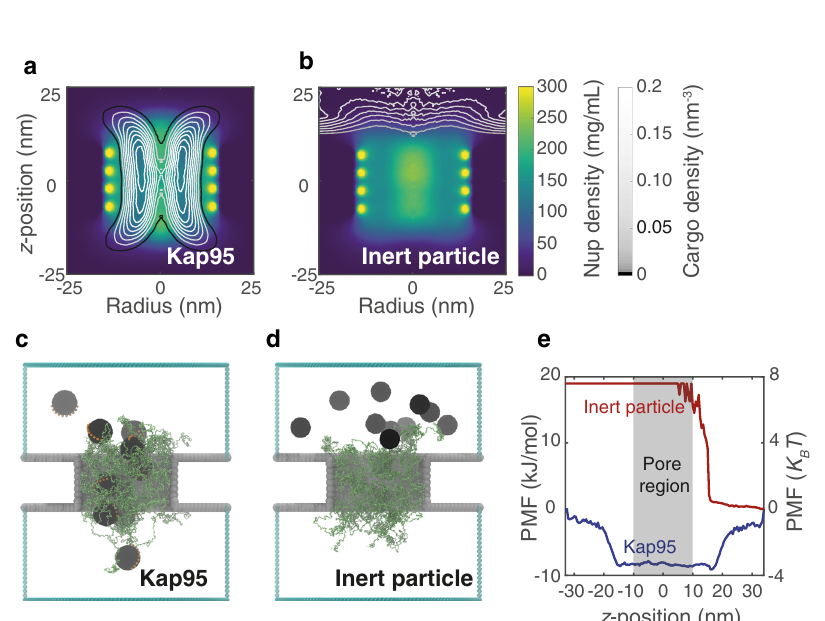
Fig. 4 Protein distribution and conductance of NupX-coated pores. a Snapshot of a biomimetic nanopore simulation. NupX proteins (following the colouring scheme of Fig. 1) were tethered with a grafting distance of 5.5 nm (yellow, top inset) to a cylindrical occlusion made of inert beads (grey). Pore diameters ranged from 15 to 70 nm, where the pore thickness was 20 nm throughout. Bottom inset: highlight of a single NupX protein (purple) within the NupX meshwork. b Axi-radial map (averaged over time and in the azimuthal direction) of the protein density within a 30-nm NupX-lined nanopore, from 6 μ s simulations. Dark colours indicate regions of low density, brighter colours indicate regions of high density. The collapsed domains of the NupX proteins form a high-density central plug. The high-density regions near the pore radius (15 nm) coincide with the anchoring sites of the NupX proteins. c Density distributions (thick lines) for the pore (blue, |z| < 10 nm) and access (red, 10 nm < |z| < 40 nm) regions. Dashed curves indicate the average density within 1-nm thick slices in the z -direction. d Radial density distributions ( z -averaged) for NupX-lined nanopores with diameters ranging from 15 to 70 nm (darker and lighter colours denote smaller and larger diameters, resp.). The curve for 30 nm is emphasized. An increase in pore size beyond 30 nm leads to a decrease in the pore density along the pore ’ s central channel. e Side-view and top-view visualizations of 20, 30, and 45 nm diameter NupX-lined nanopores. For nanopores with diameters smaller than 25 nm, the pore region density decreases due to an expulsion of the collapsed NupX domains towards the access region. For nanopore diameters larger than 40 nm, the pore density decreases and a hole forms. For nanopore diameters of 25 – 30 nm, the pore region is sealed by the NupX cohesive domains. f Conductance scaling for bare and NupX-coated nanopores. Open circles indicate conductance measurements for bare (red) and NupX-coated (green) pores. Squares indicate time-averaged conductance values obtained from MD simulations via a density – conductance relation (Methods). Error bars indicate the standard deviation in the conductance and are smaller than the marker. Second-order polynomial fi ts to the bare pore (experimental) and the simulated conductance values are included as a guide to the eye. g , h Axi-radial density maps for FG- and GLFG-motifs, respectively. Both types of motif localize in the dense central region, indicating that there is no spatial segregation of different types of FG-motifs in NupX-coated nanopores.